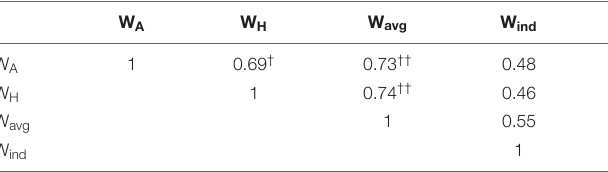
TABLE 1 | Correlation matrix showing the comparison of the correlation coefficients between sensitivity profiles from the respective filters, averaged across all subjects (ANOVA, p = 0.0025; post-hoc [W ind vs. W A , W H , W avg ] < [W H vs. W A ] † < [W avg vs. W A , W H ] †† ).